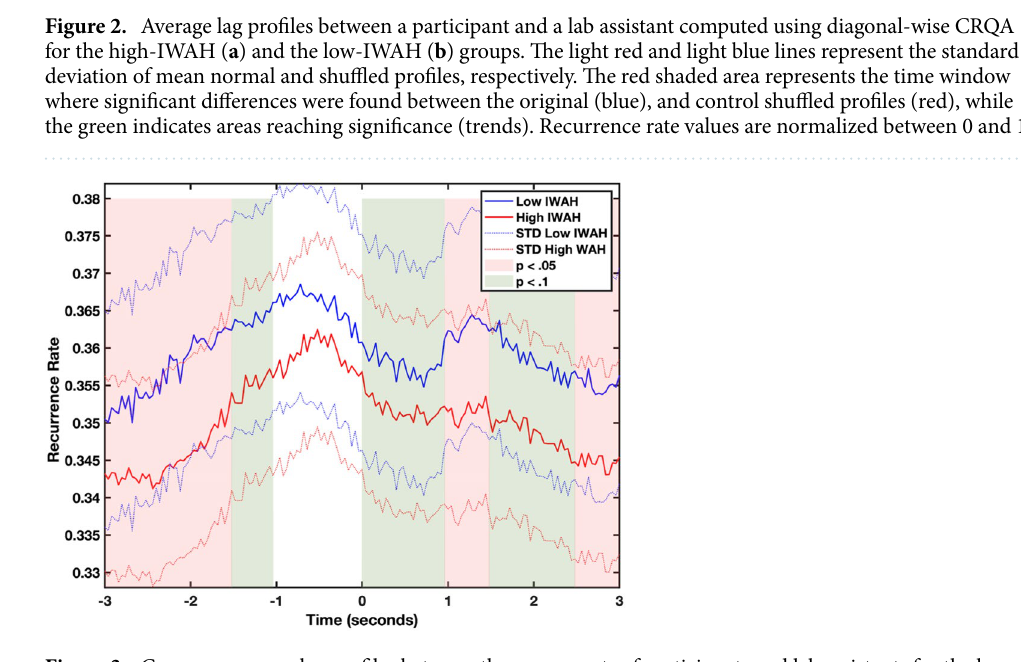
Figure 3. Cross-recurrence lag profiles between the movements of participants and lab assistants for the low- IWAH (blue) and the high-IWAH (red) groups. Differences in recurrence rate were tested in blocks of 0.5 s. Significant differences ( p < 0.05) between the lag profiles are shadowed in red while trends ( p < 0.1) are shadowed in green. Negative values in time indicate that a participant led the interaction, while positive values suggest that a lab assistant did. Recurrence rate values are normalized between 0 and